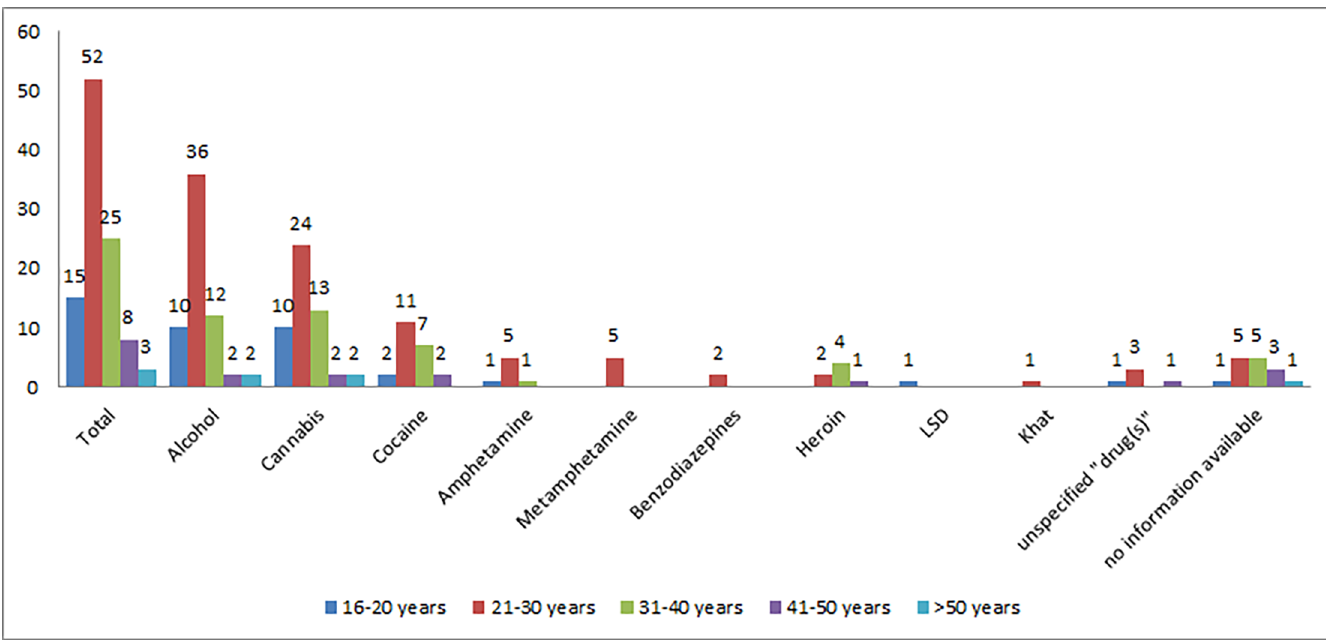
Fig 2. Age groups and reported substance use (count of cases).